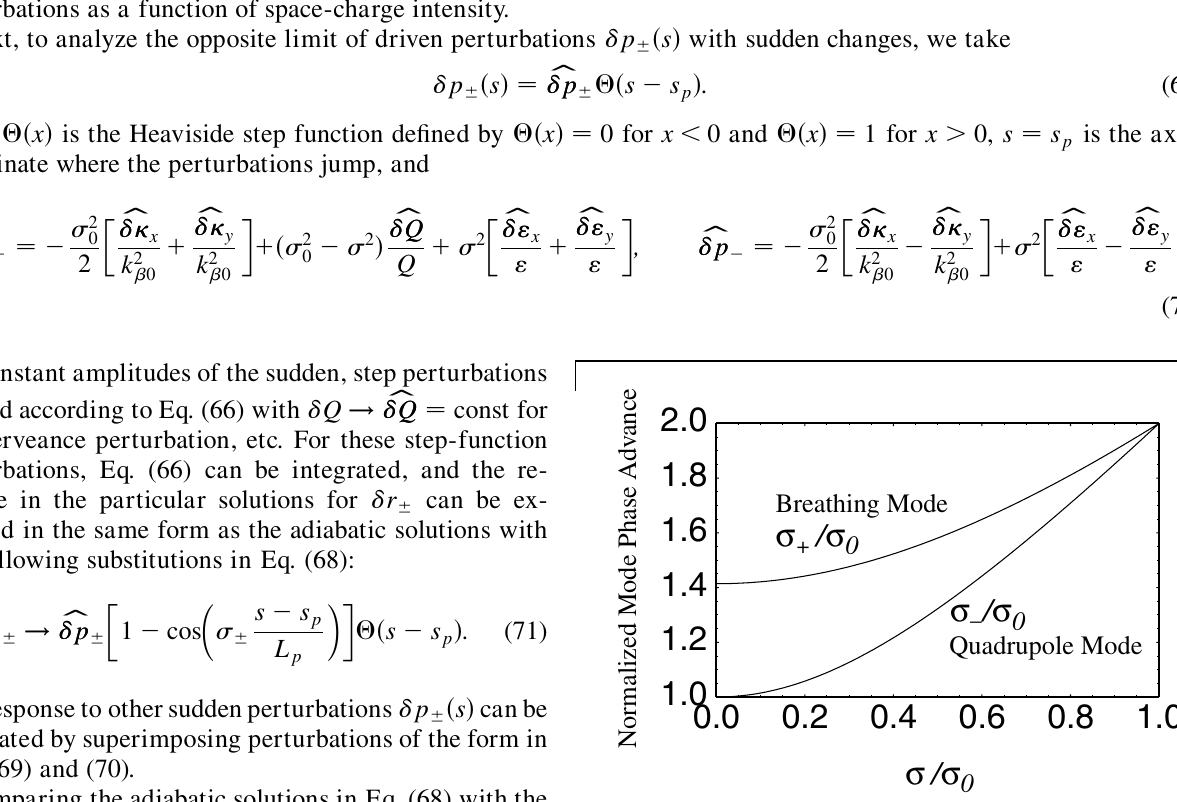
and (cid:24) (cid:2) =(cid:24) of the 0 0 for a 0